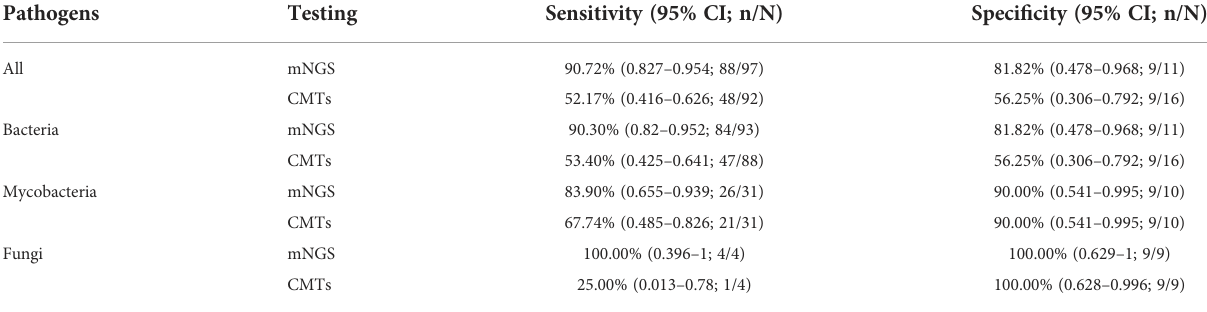
TABLE 2 Diagnostic performance of mNGS vs. CMTs in spinal